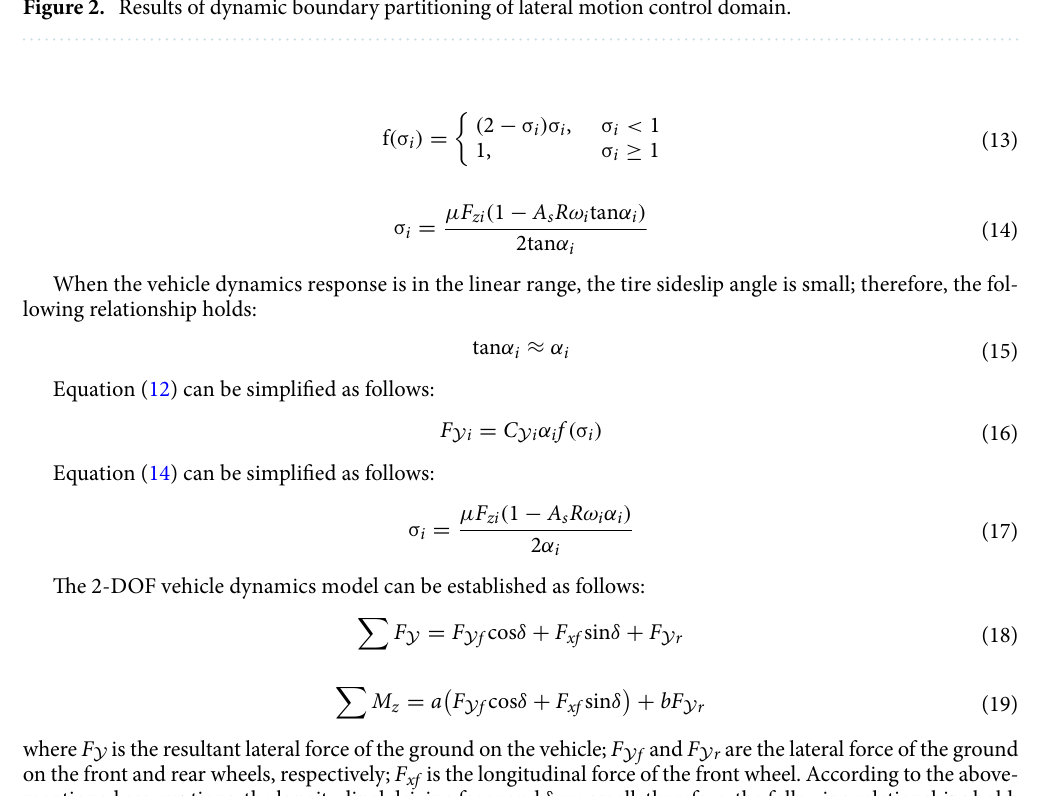
Figure 2. Results of dynamic boundary partitioning of lateral motion control